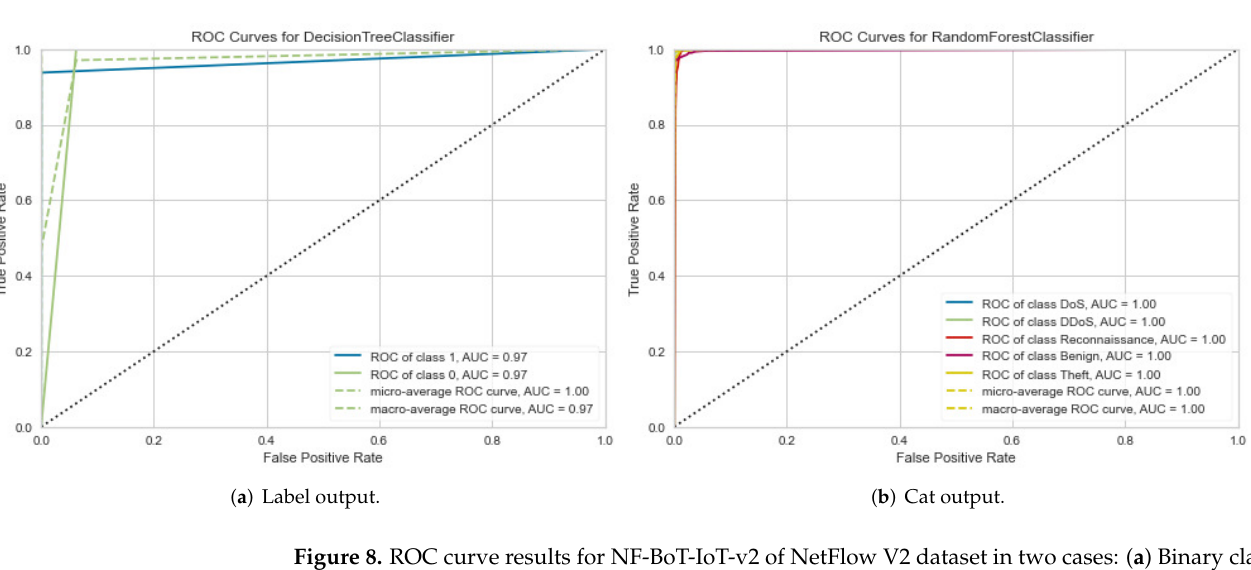
Figure 8. ROC curve results for NF-BoT-IoT-v2 of NetFlow V2 dataset in two cases: ( a ) Binary class output and ( b ) Multiclass